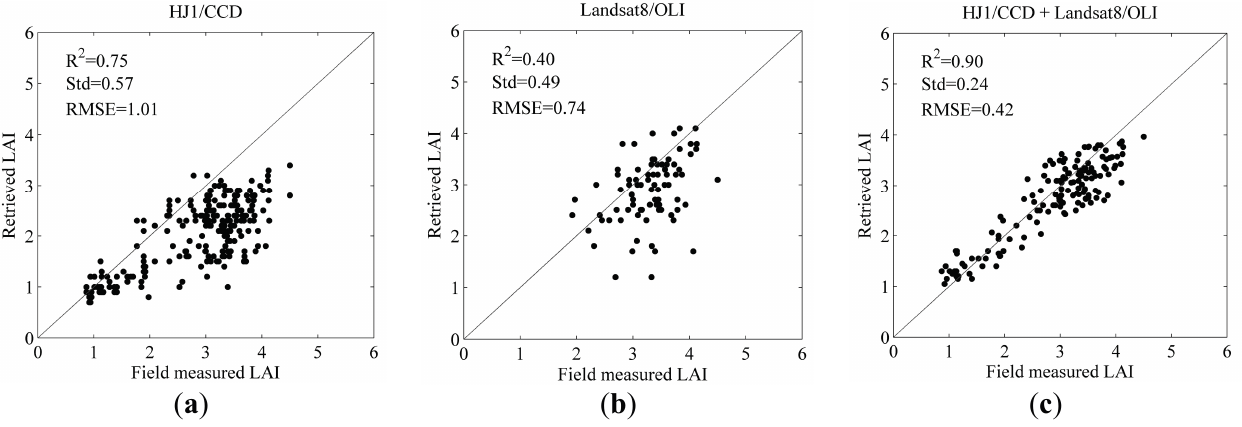
Figure 12. Comparison of the LAI inversions with the field measurements by WSN and LAI-2200 for crops from July to August 2013. ( a ) LAI inversions of HJ1/CCD data; ( b ) LAI inversions of Landsat8/OLI data; ( c ) LAI inversions of the combining HJ1/CCD and Landsat8/OLI dataset.